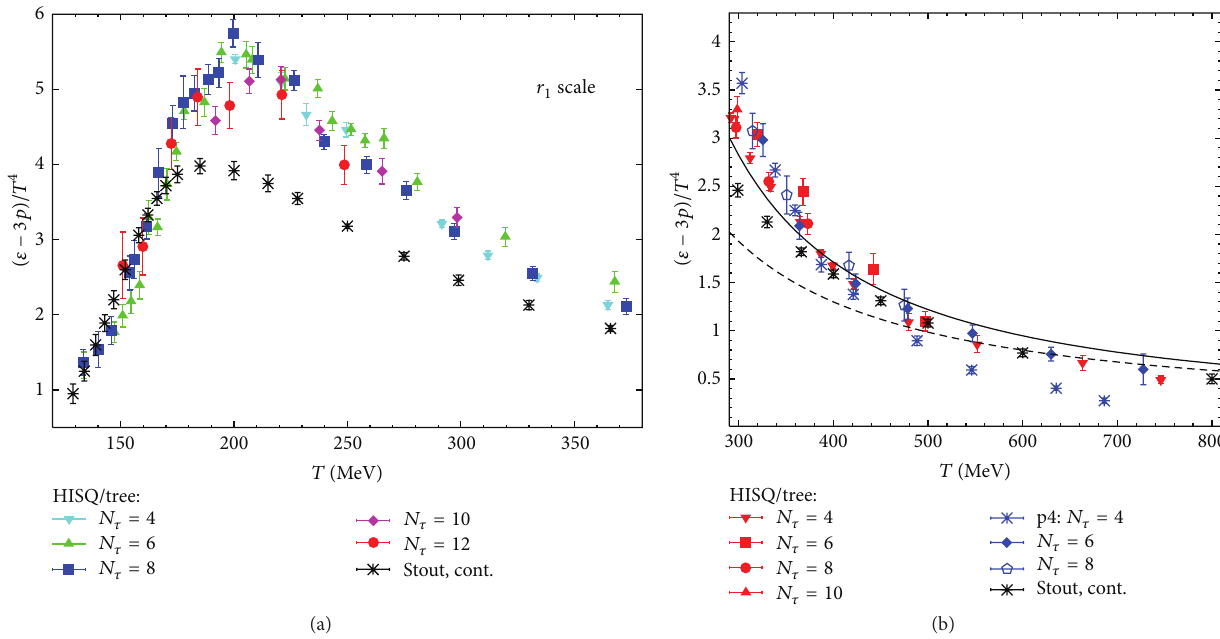
Figure 2: The results for the trace anomaly using the HISQ action for low (a) and high (b) temperatures for lattice sizes with temporal extent 4𝑁 𝑁 𝜏 and spatial size 𝜏 , from [48]. Also in (b), the HISQ results are compared to the results using p4 fermions, which has an improved behaviour at high temperatures and to the continuum perturbation theory results at 1-loop (solid line) and 2-loop (dashed line) for the trace anomaly. The stout data are the continuum estimates from the 𝑁 𝜏 = 6, 8, 10 data in [19].